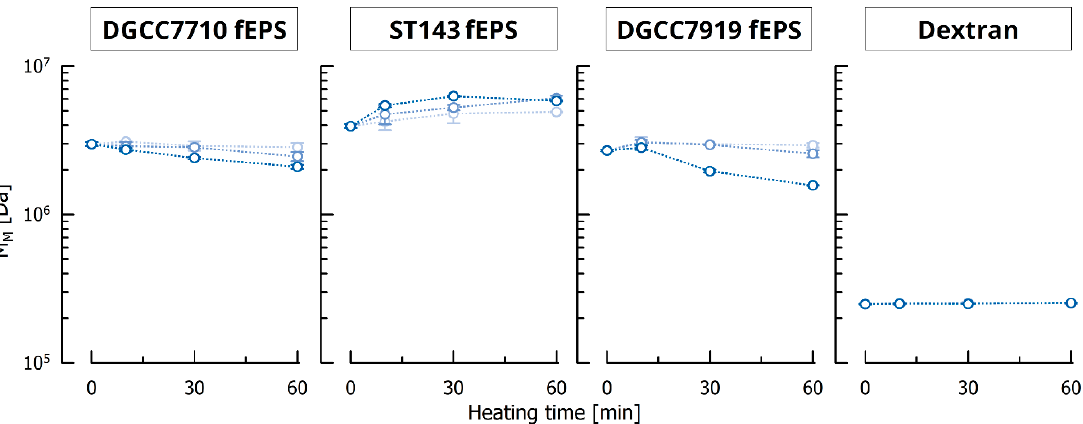
Figure 1. Weight average molecular mass M M of EPS after thermal treatment of 1.0 g/L solutions at 60, 80 and 90 °C (light to dark blue).